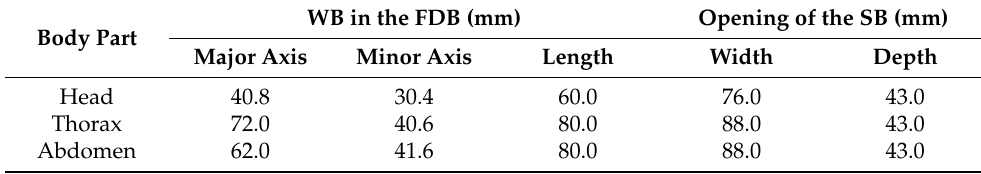
Table 2. Sizes of WBs in the FDB and openings of the SB that are designed in this study.